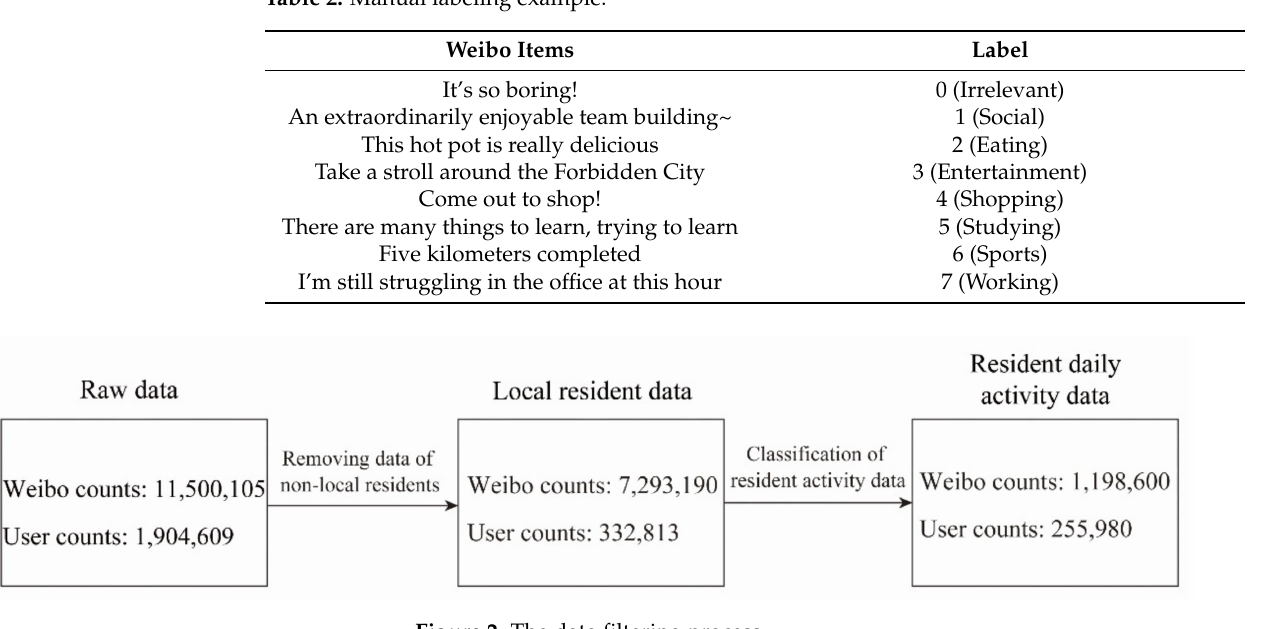
Figure 2. The data filtering